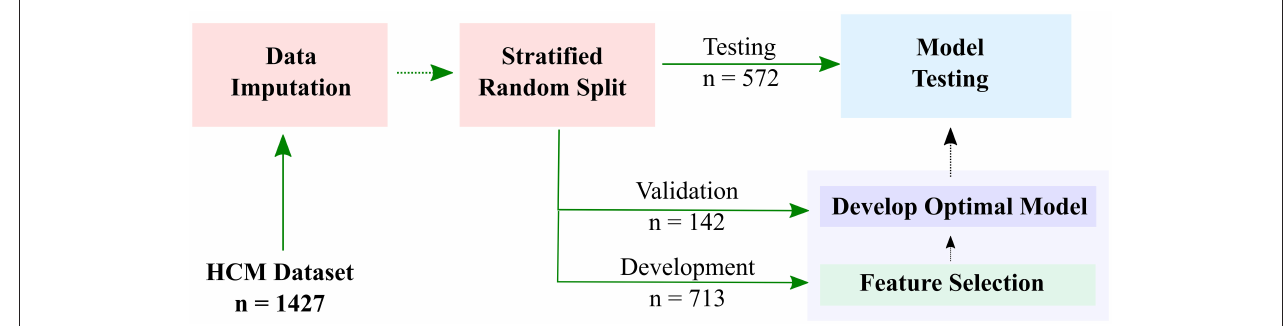
FIGURE 1 | Workflow of developing a machine learning-based model for predicting risk of heart failure (HF) in hypertrophic cardiomyopathy (HCM) patients. Datasets are imputed and split into development (50%), model-selection (10%), and independent-validation (40%) subsets. The development subset is used to select the most important features, and the validation subset is used for model optimization. The final HF stratification model is then used to predict HF risk in the testing